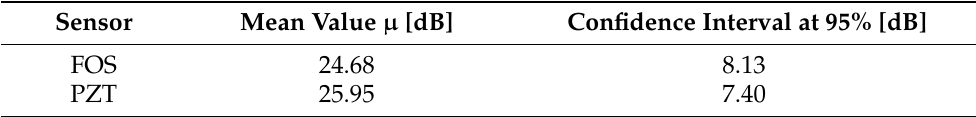
Table 2. The mean value and critical value at 95% for FOS- and PZT-collected